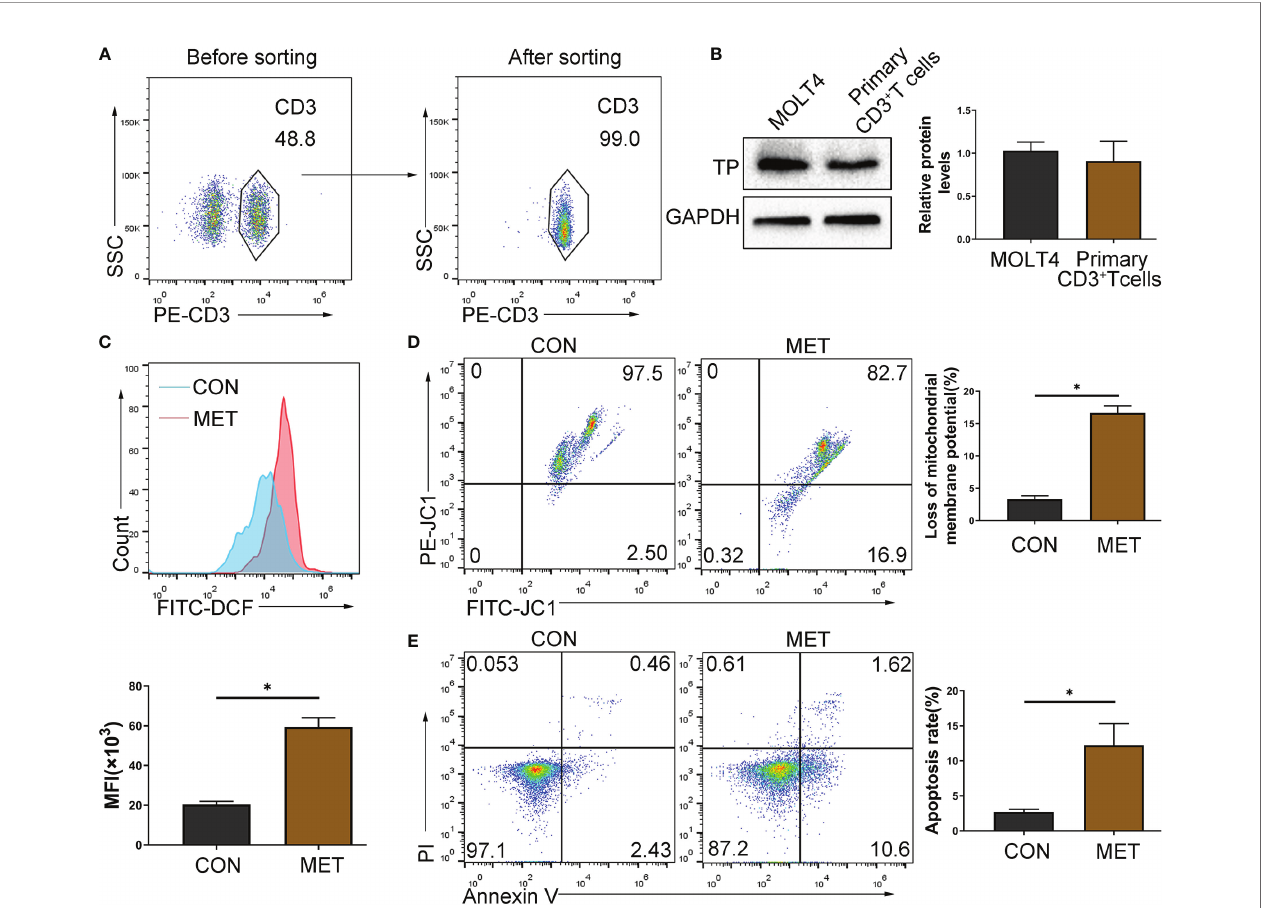
FIGURE 4 | CAP can induce apoptosis of TP-expressing T cells. (A) CD3 + T cells were sorted by immunomagnetic beads from the spleen of mice and identi fi ed by staining with PE-CD3 antibody. (B) The protein levels of TP were evaluated using western blot assay. (C) Mononuclear cells extracted from the spleen of mice gavaged with metronomic chemotherapy dose of CAP on day 7 were collected and gated by CD3, and then the ROS level was detected with fl uorescent probes (DCFH-DA) using fl ow cytometry; (D) The proportion of cells with reduced mitochondrial membrane potential was detected using fl ow cytometry; (E) The apoptosis of T cells was detected by Annexin V and PI staining. Data are shown as mean ± SD. * P <